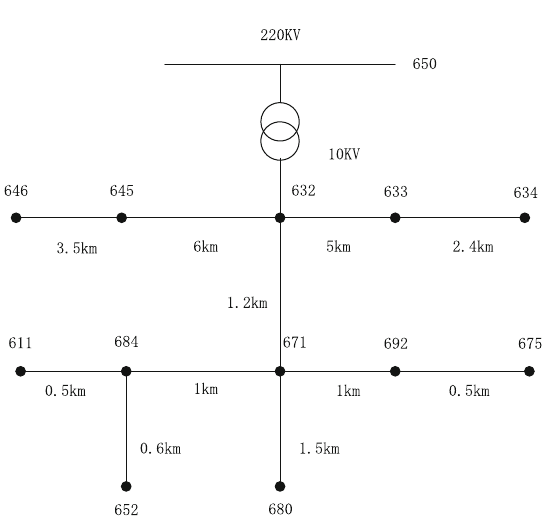
Fig. 7 The IEEE 13-node simulation model